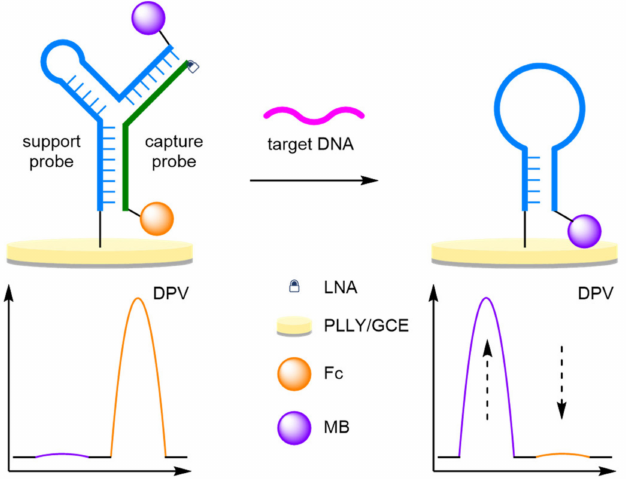
Figure 11. Schematic representation of a biosensor for the detection of single point mutation via locked nucleic acid strand displacement